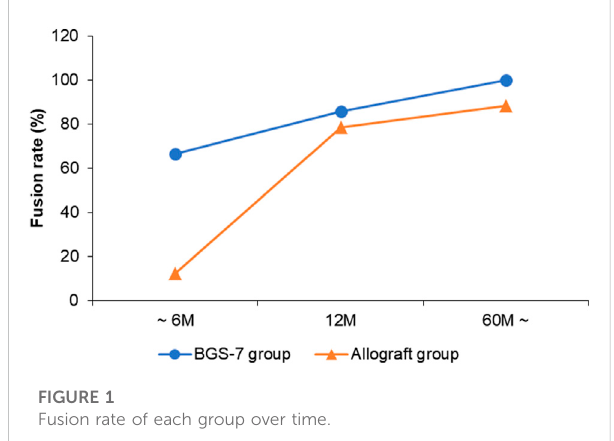
FIGURE 1 Fusion rate of each group over